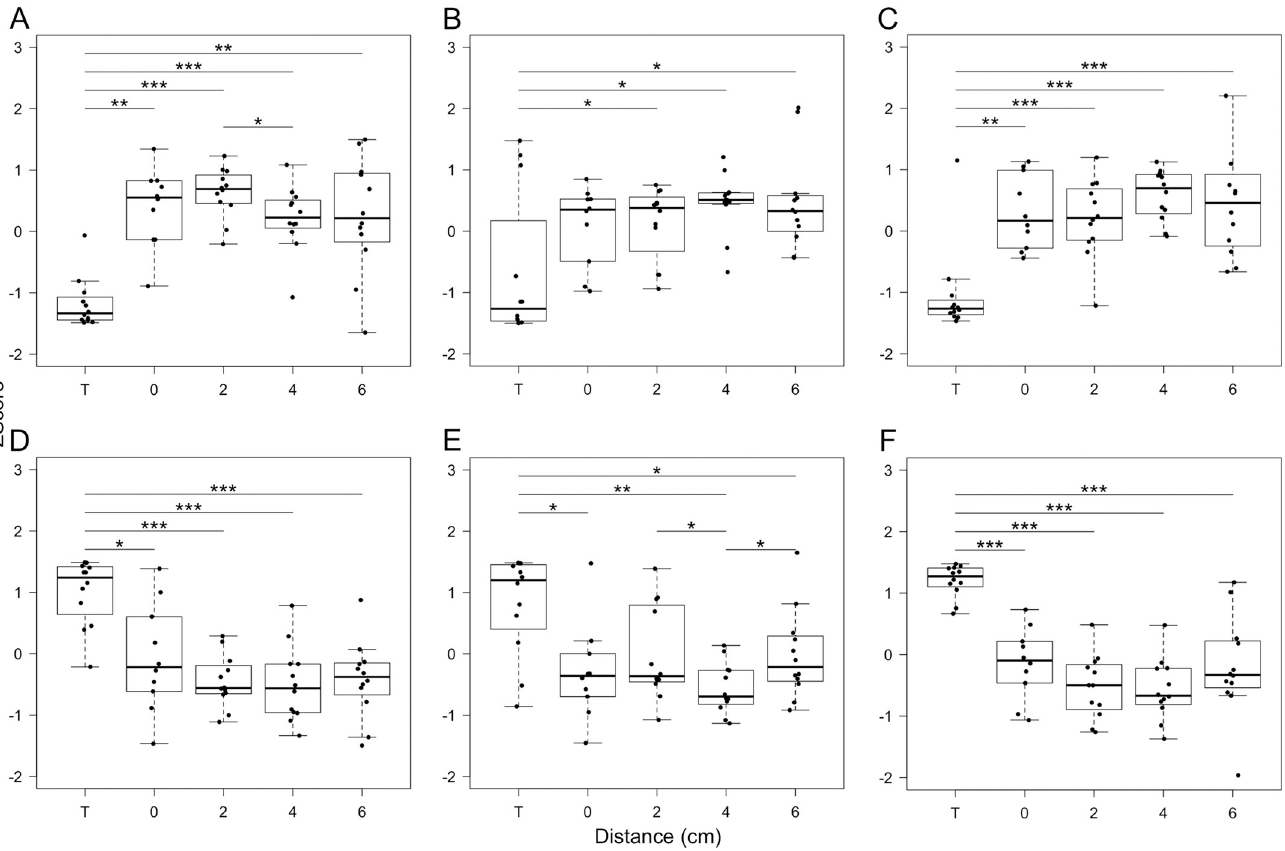
Fig 2. Boxplots of gene expression levels of selected prognostic genes including NFIB (A), SELENBP1 (B), BTG2 (C), FOXM1 (D), RRM1 (E), and EZH2 (F) in tumor and adjacent non-tumor lung tissue at different distances from the tumor. The y-axis represents mean standardized gene expression values. The x-axis represents the geographical tissue samples at the tumor (T) and non-tumor sites at 0, 2, 4, and 6 cm away from the tumor (n = 12). Box boundaries, whiskers and centre mark in boxplots represent the first and third quartiles, the most extreme data point which is no more than 1.5 times the interquartile range (IQR), and median, respectively. � p < 0.05, �� p < 0.01, ��� p < 0.001.